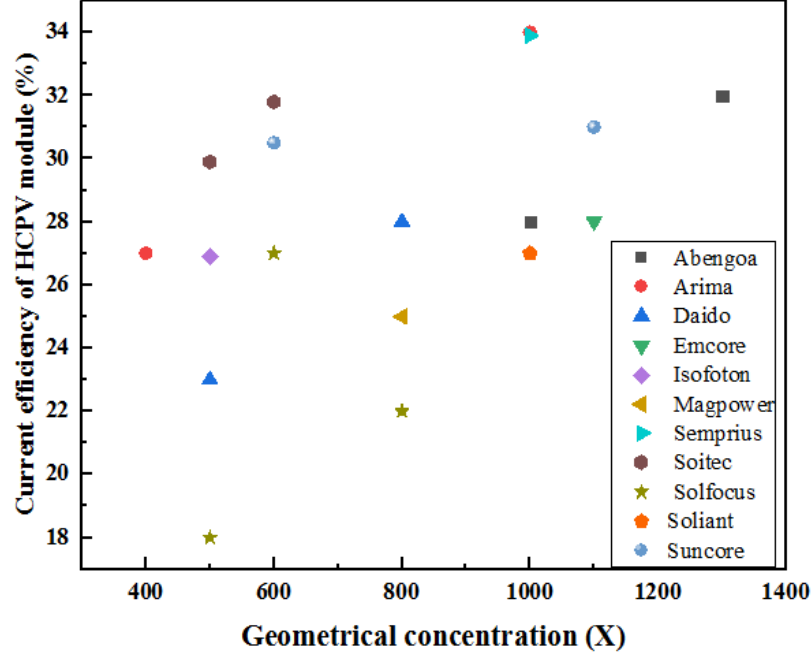
Figure 43. Current efficiency of HCPV modules of different commercial technologies (data sheets) versus geometric